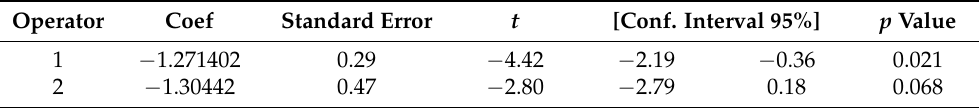
Table 5. Linear regression model for the correlation of the sequence of the model preparation and the operator error in implant